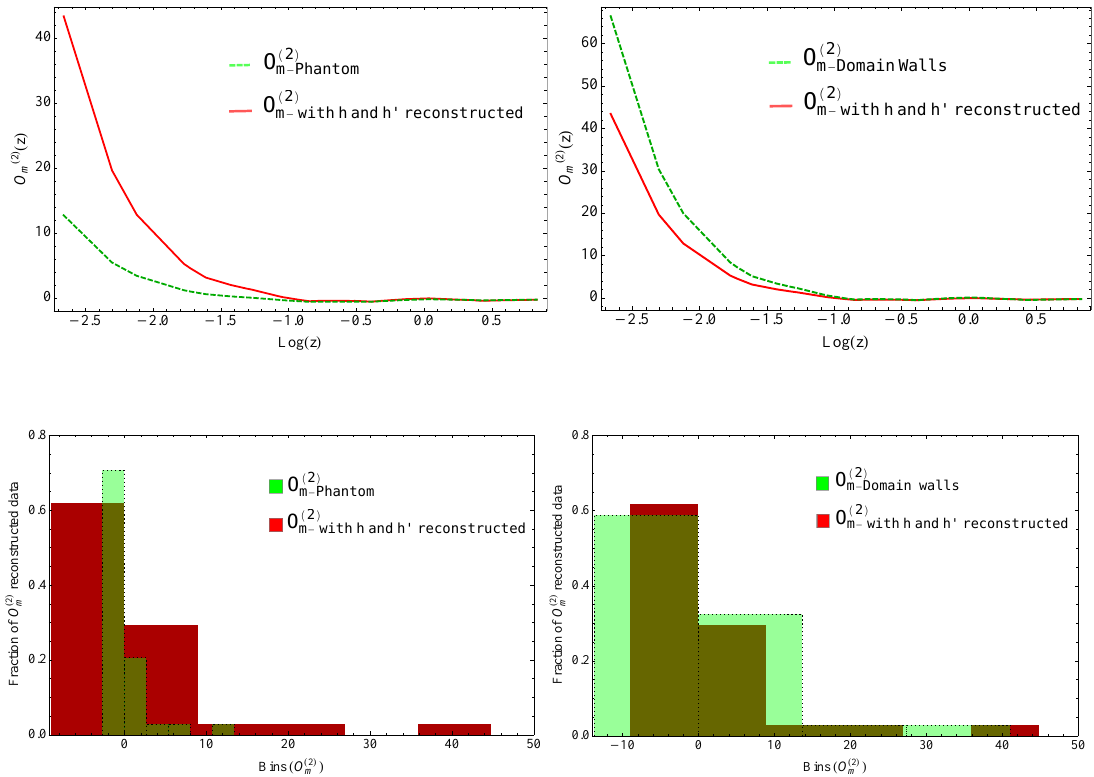
( 2 ) m ( 2 ) m ( 2 ) m diagnostic reconstructed in ( 2 ) m reconstructed ( 2 ) < 0, and then, m ( 2 ) m deviation between this data and each DE model